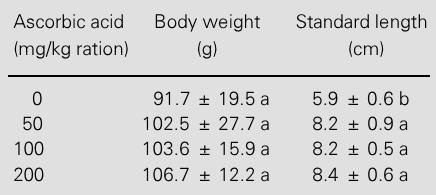
Table 2 - Effect of ascorbic acid on body weight and length of P. mesopotamicus Holmberg, 1887, at the end of the experiment (24 weeks) com- pared to control. Data are reported as means – SEM for 30 fish in each group. Averages followed by the same letter did not differ by the Tukey test